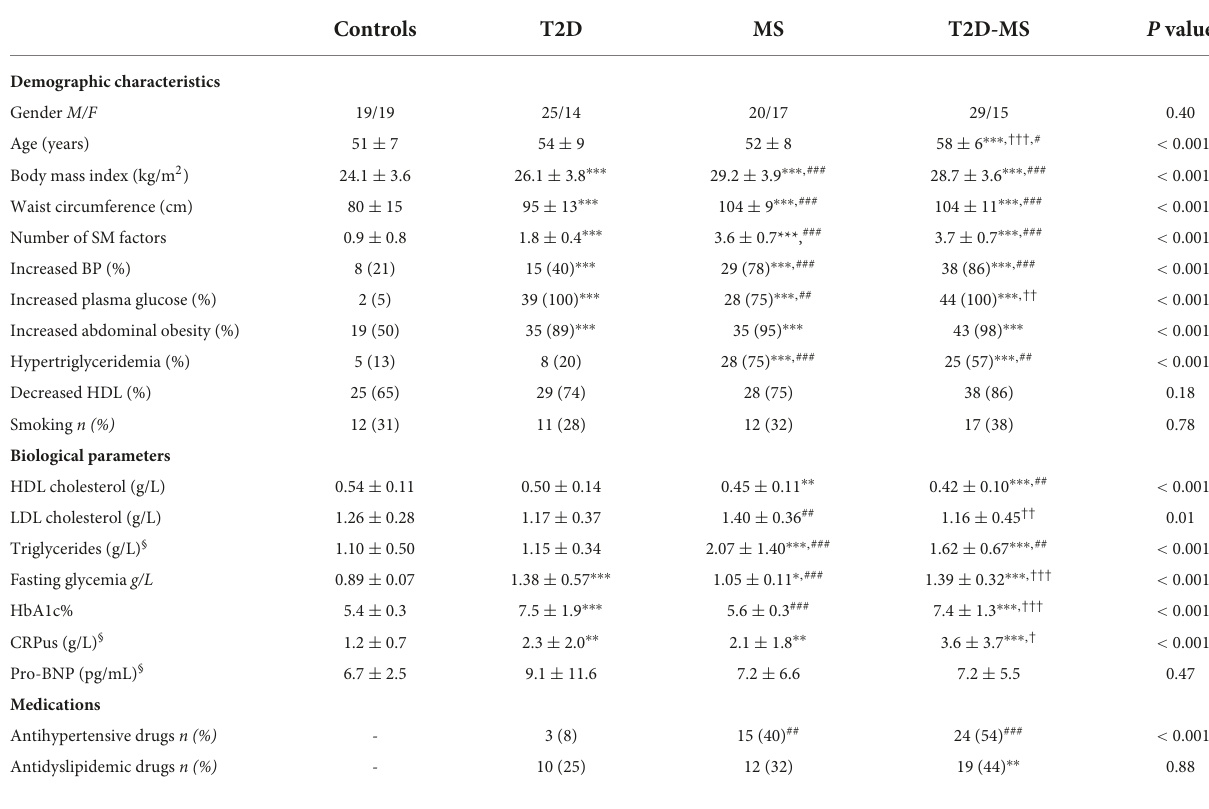
TABLE 1 Clinical